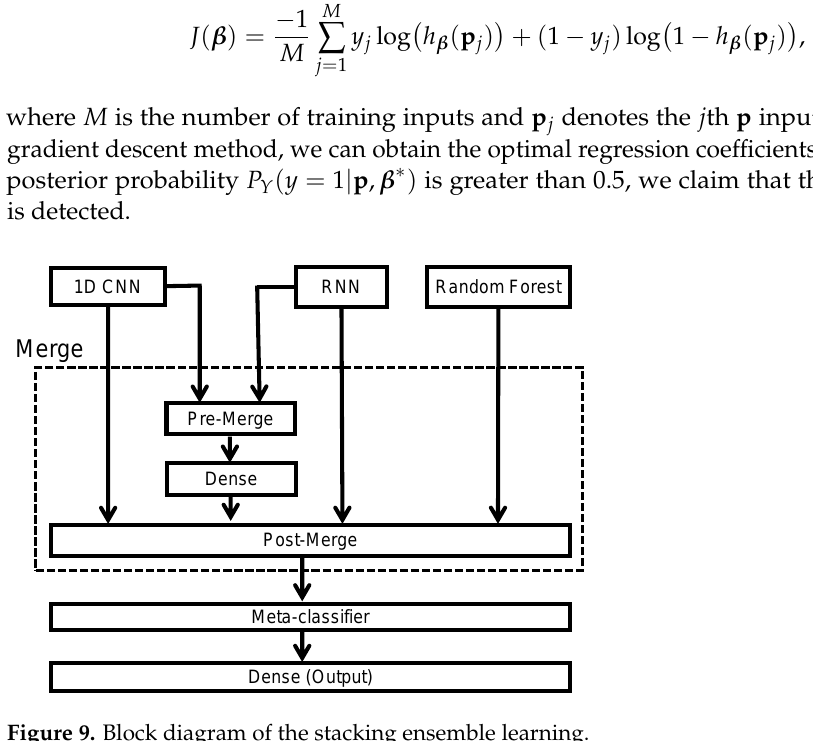
Figure 9. Block diagram of the stacking ensemble